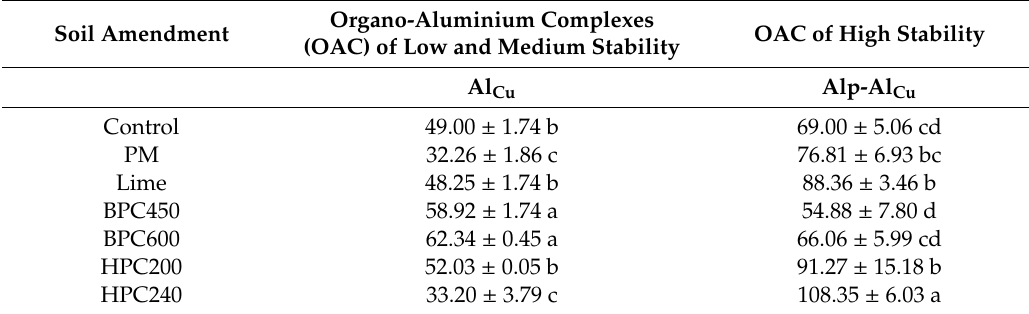
Table 2. Organo-aluminium complexes of low, medium and high stability in response to addition of soil